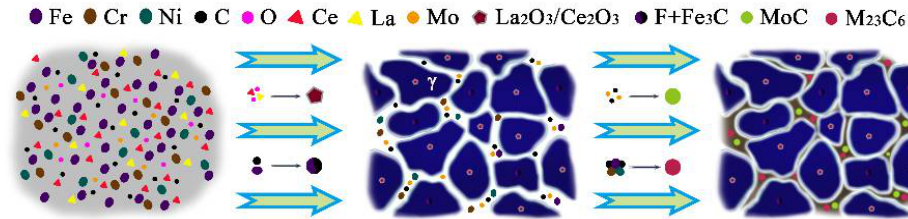
Figure 11. Schematic diagram of different cladding